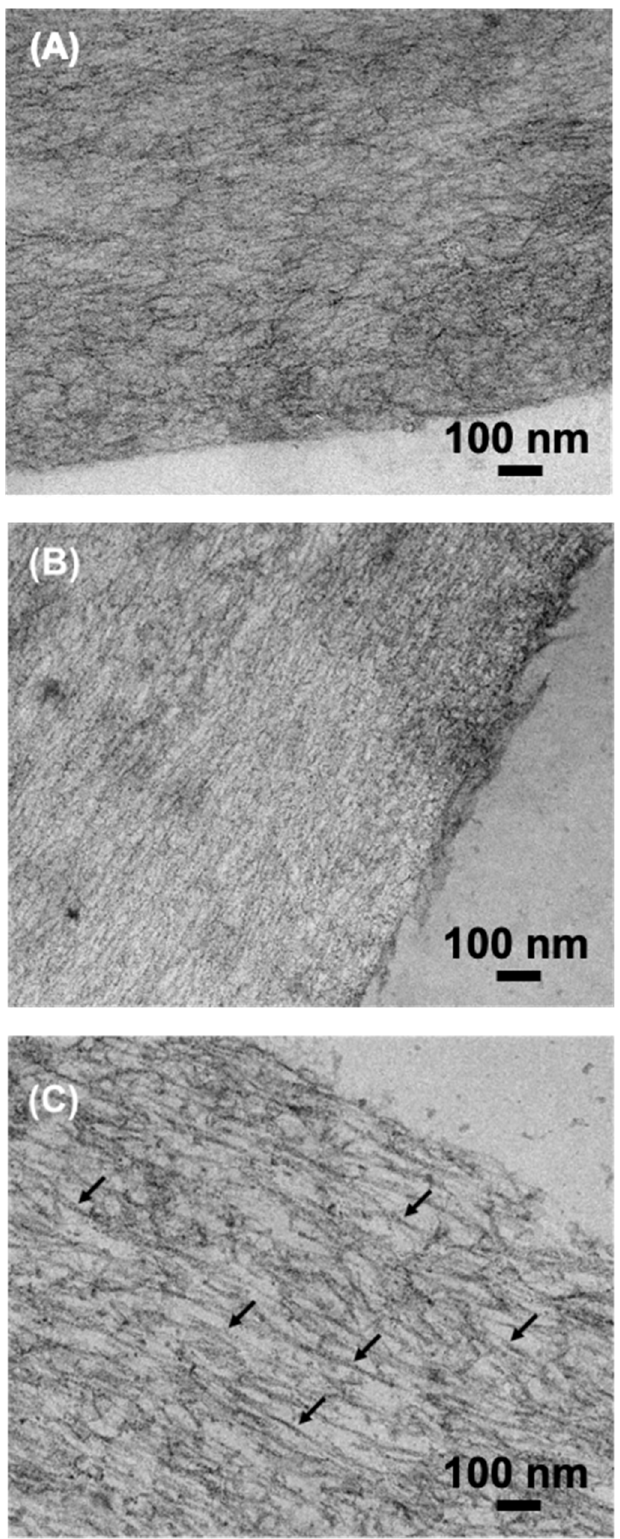
Figure 6. TEM of sample F-4VBC*. ( A ): control F-4VBC* obtained following wet spinning and UV curing (no PBS incubation). ( B ): sample F-4VBC* obtained via sequential wet spinning, 24-h incubation in PBS and UV curing. ( C ): sample F-4VBC* obtained via sequential wet spinning, 72-h incubation in PBS and UV curing. Black arrows indicate re-folded collagen-like fibrils in vitro.